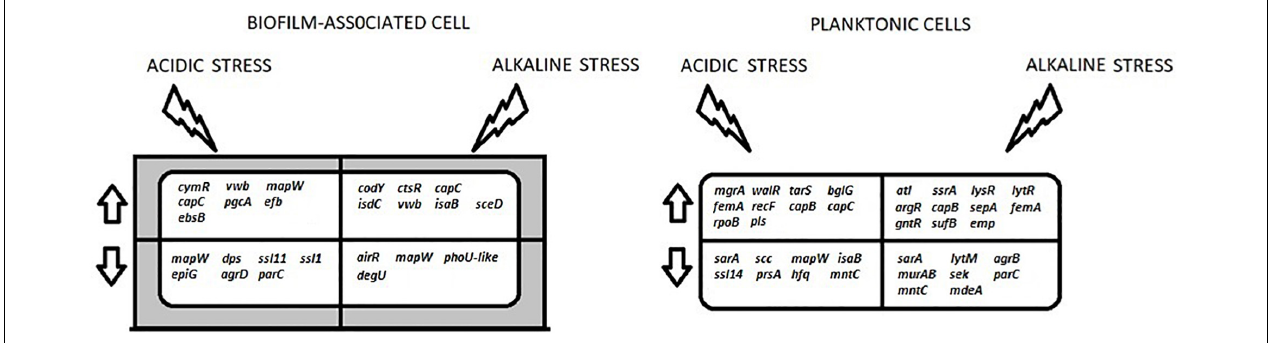
FIGURE 2 | A summary of the key differentially expressed genes that are discussed in this study. These genes are involved in the processes of transcription regulation ( ctsR , argR , lysR , ssrA , lytR , cymR , bglG , walR , rpoB , mgrA , airR , degU , sarA , agrD , phoU-like , agrB , dps , hfq ), cell wall biosynthesis ( capB , capC , tarS , pgcA , ebsB ), BF formation ( mapW , efb , isdC , vwb , trgX , emp , ssaA , mntC , epiG , scc ), autolysis ( atl , murAB , lytM ), virulence ( isaB , ssl11 , ssll1 , ssl14 , sek ) and antibiotic resistance ( femA , sepA , pls , mdeA ). The arrows indicate up- and down-regulation. The shaded area around the BF-associated cell represents the extracellular